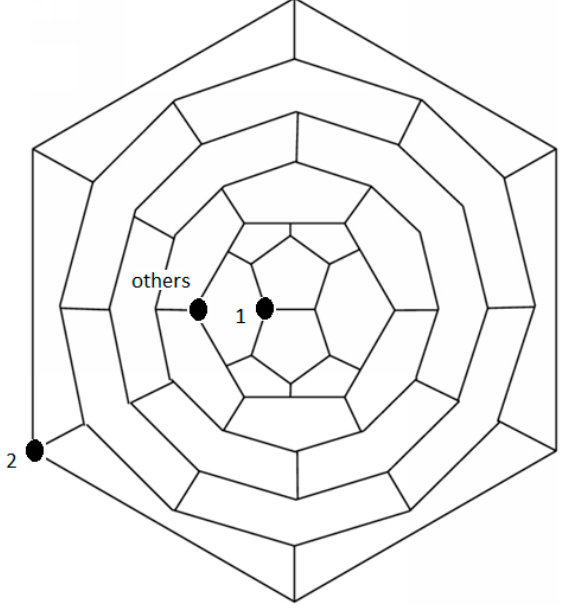
Figure 7. The molecular graph of the fullerene C 24 n +12 , for n = 3 .